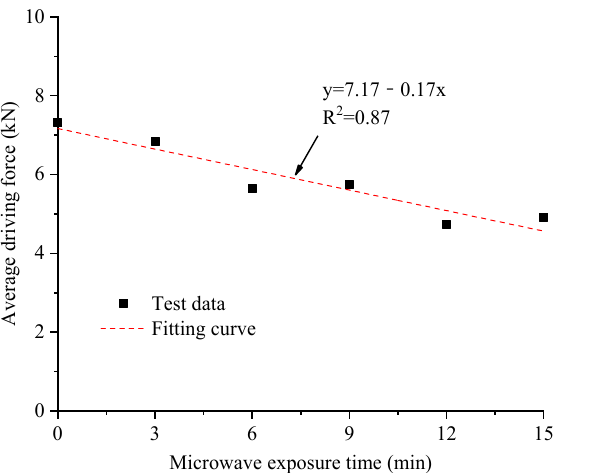
Figure 11. Relationship between the average driving force and the microwave exposure time.